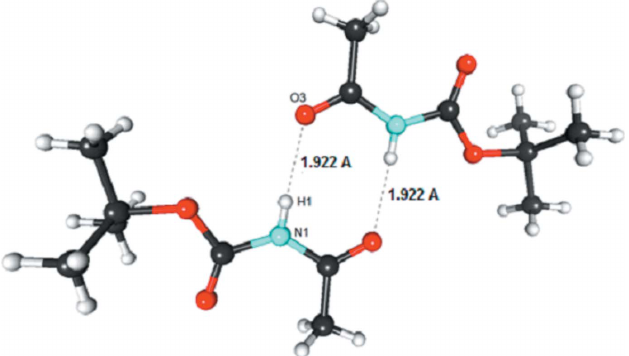
Figure 2 View of the molecular dimer linked by a double hydrogen bond.